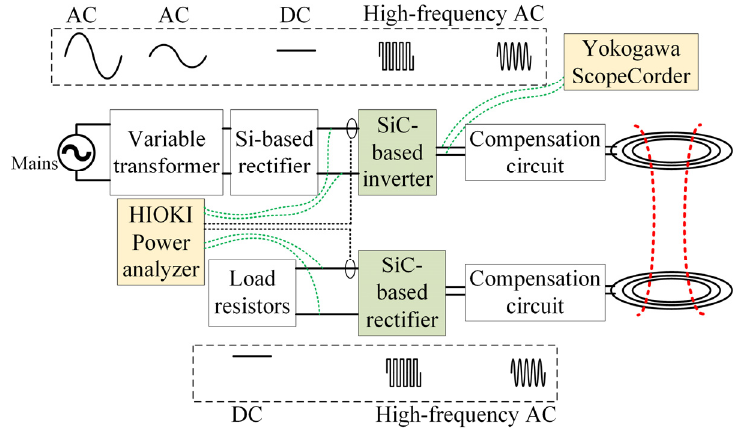
Figure 10. Configuration of the IPT prototype and the voltage or current waveforms. Input power and output power are measured before the SiC-based inverter and after the SiC-based rectifier, respectively.